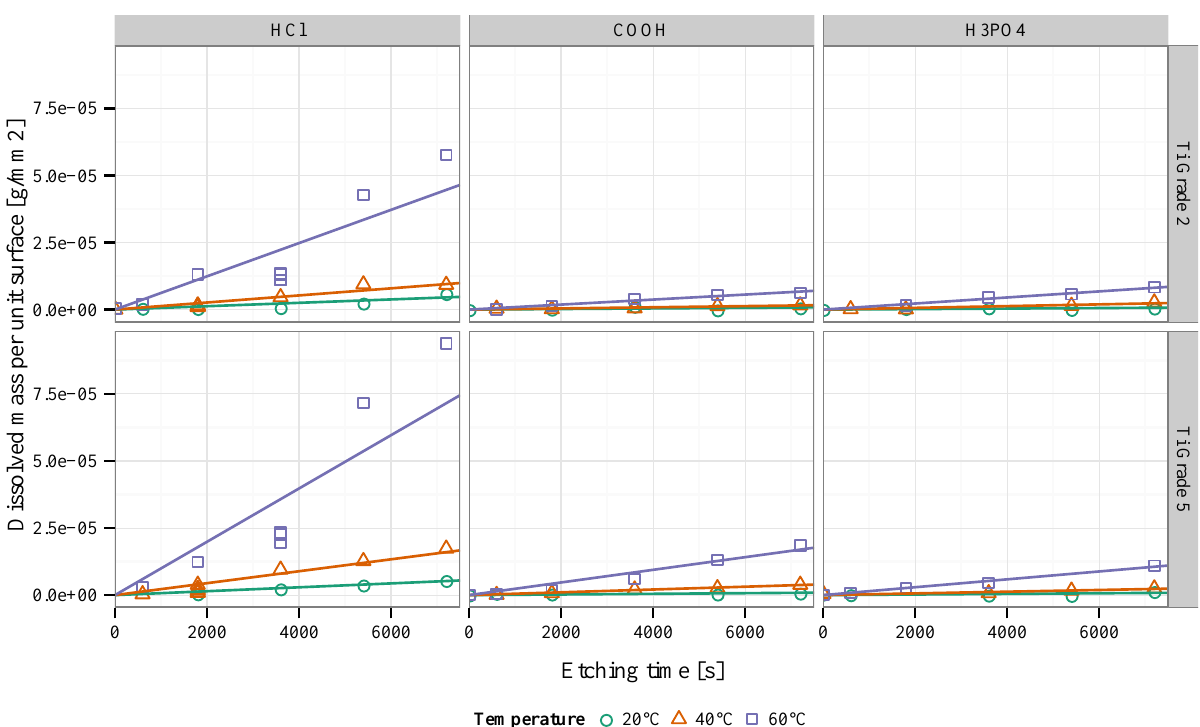
PO , in the compound of 30% (COOH) 3 4